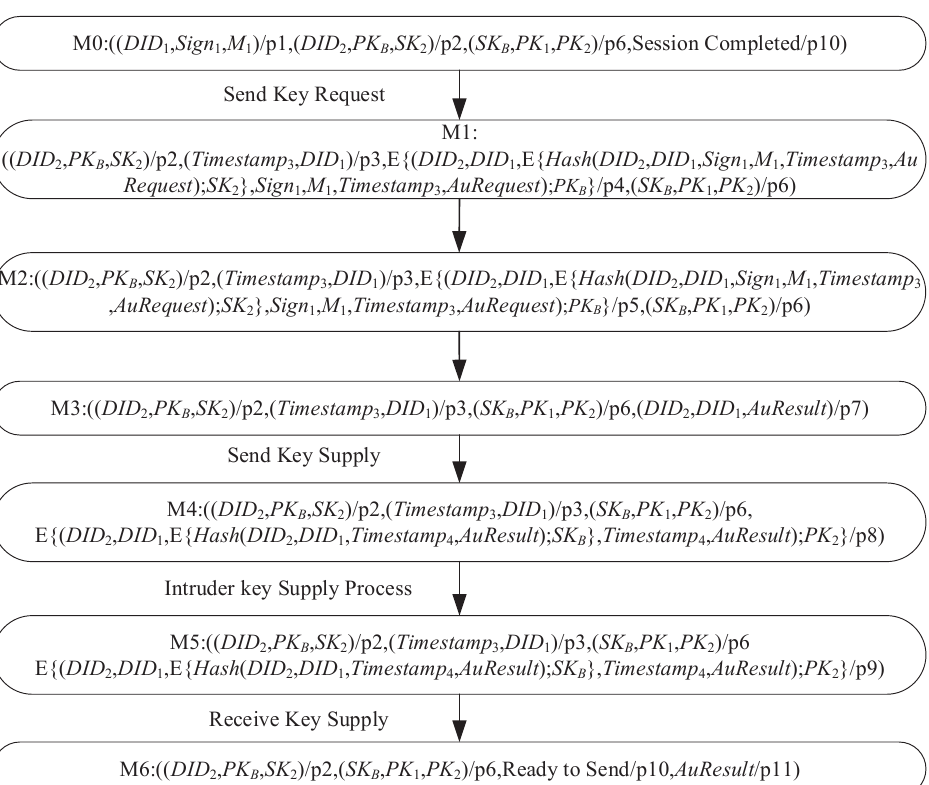
Figure 9. The public key request protocol model with the attacker.